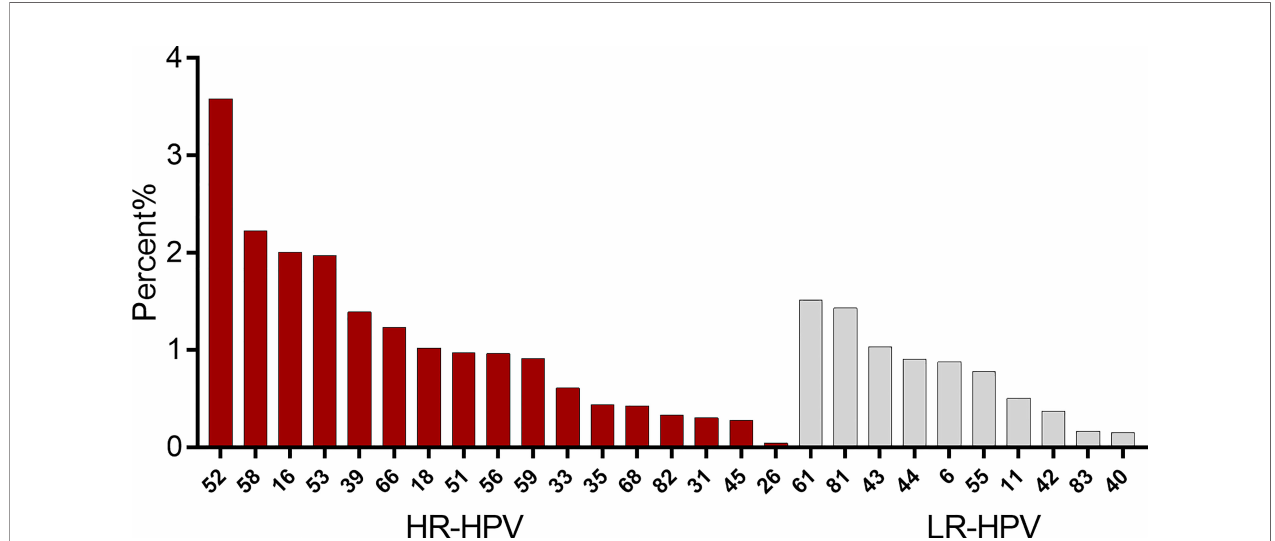
FIGURE 1 | Distribution of the total infection rate (%) for the 27 HPV subtypes (left, high-risk subtypes; right, low-risk subtypes).